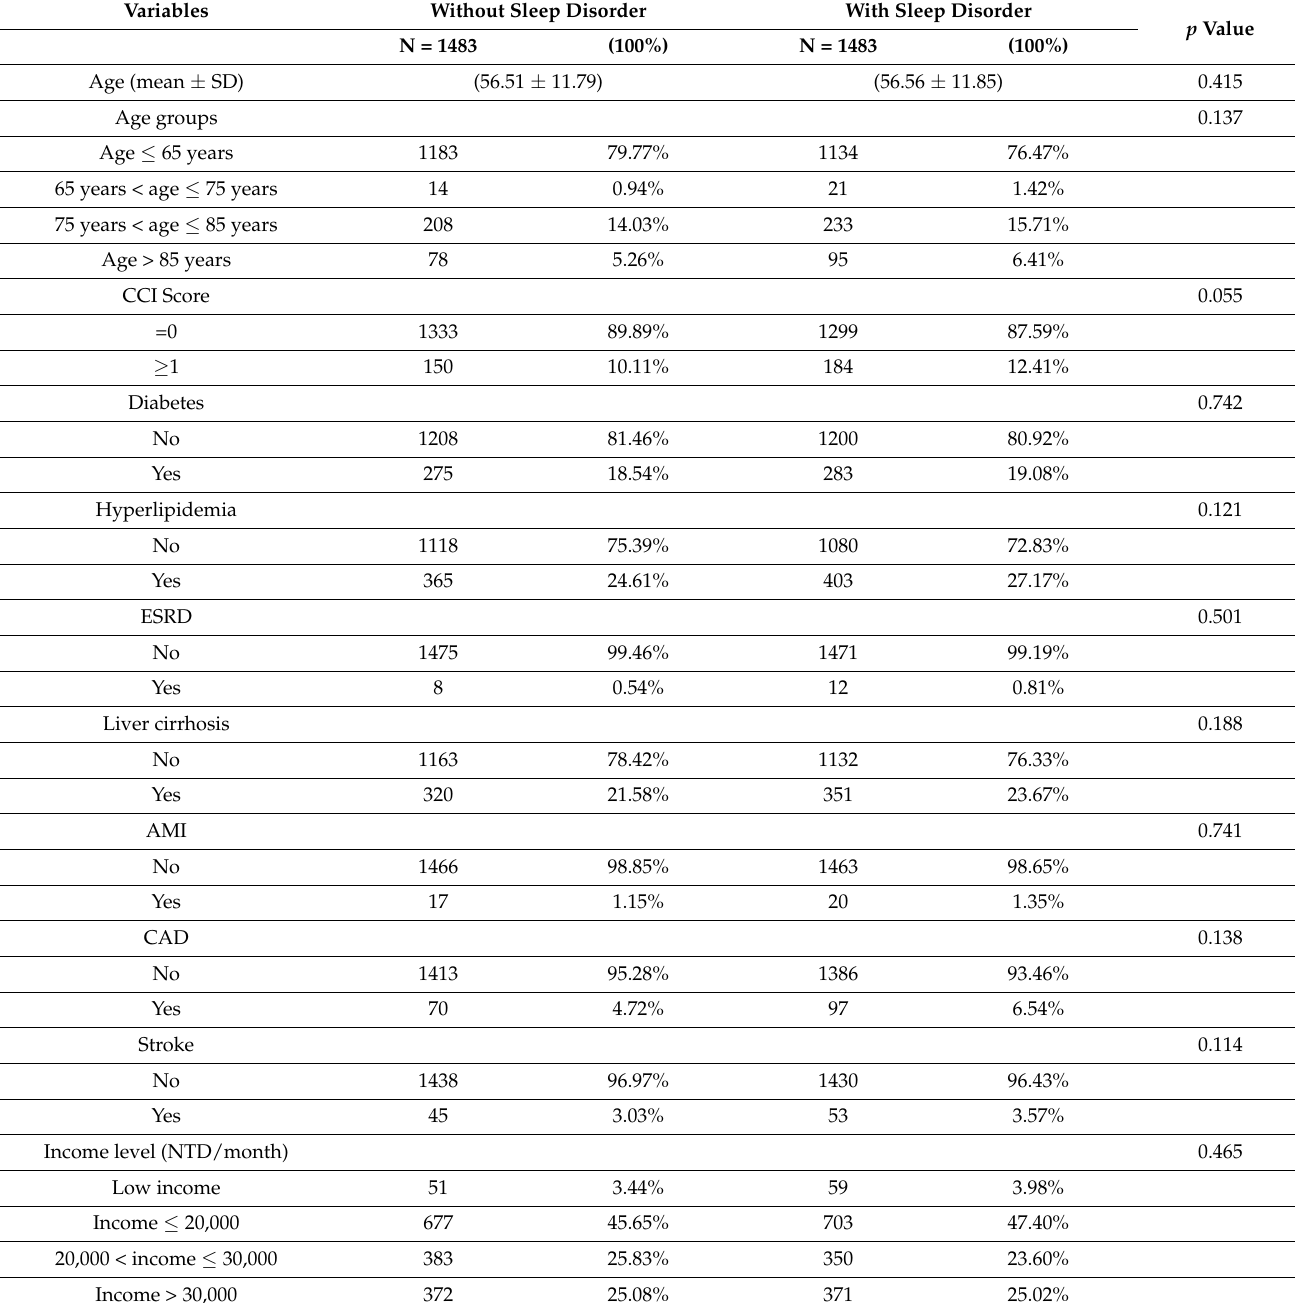
Table 1. Characteristics of propensity score-matched patients with and without sleep disorders before a diagnosis of breast